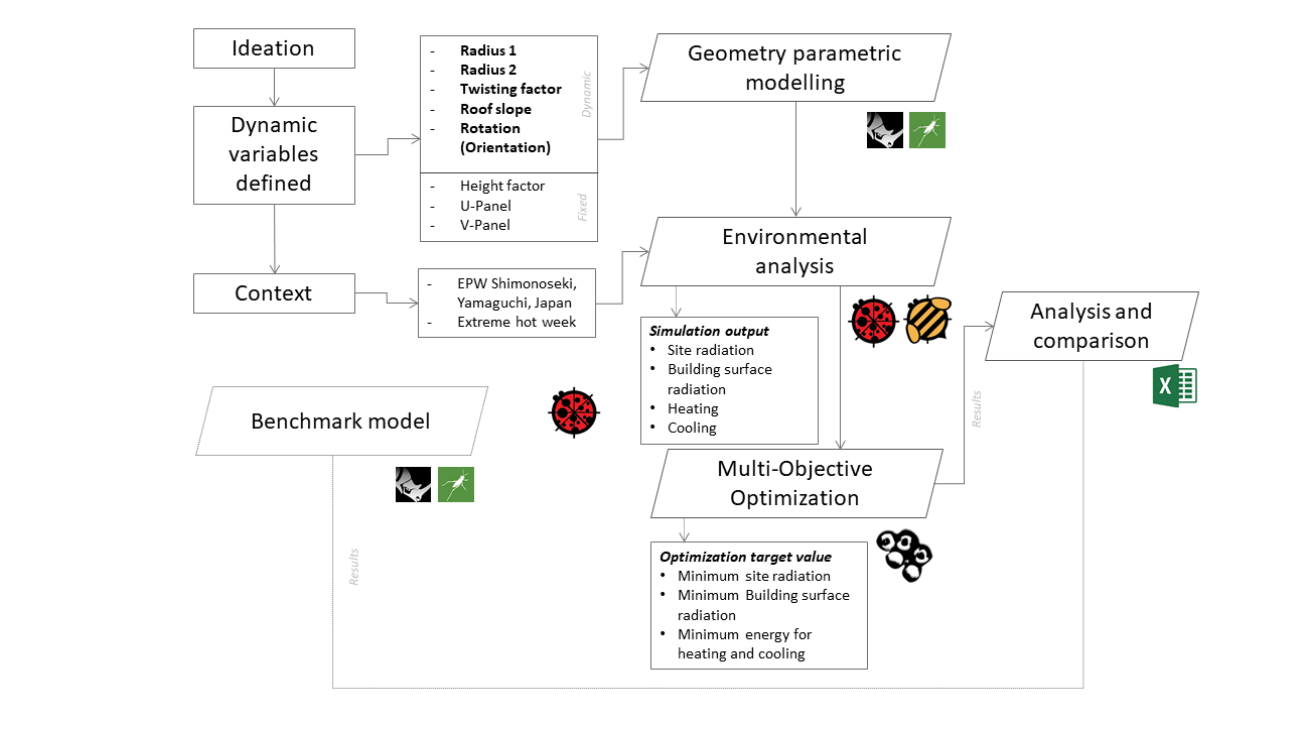
Fig. 1. Research workflow.